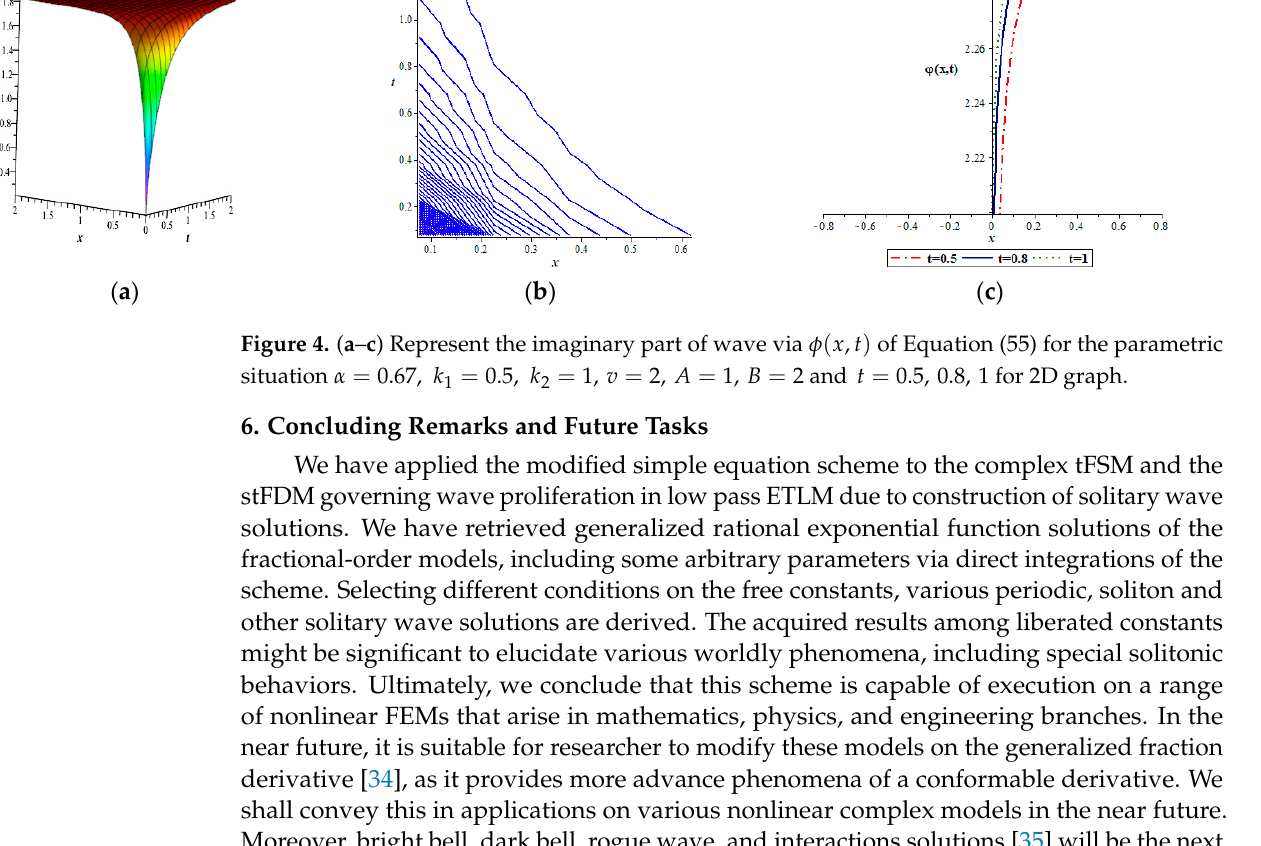
Figure 3. ( a – c ) Characterize the wave via ),( tx ====== BAvkk α 8.0,1,2,1,5.0,5.0 21